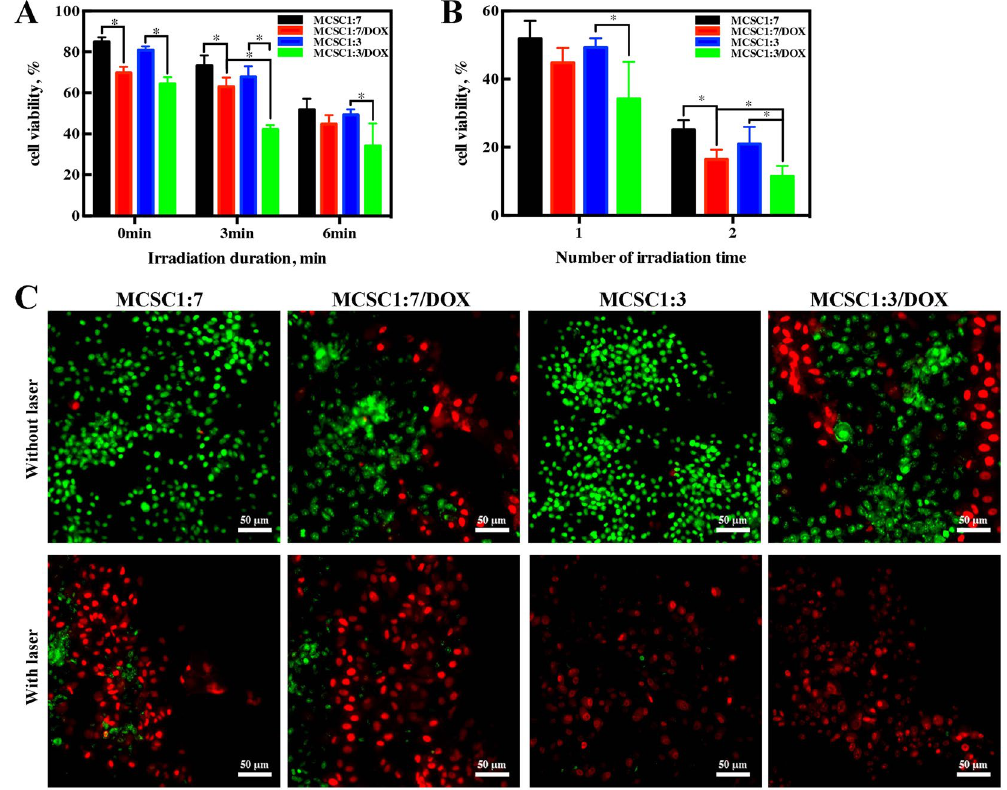
Figure 6. The scaffolds exert potent anti-proliferative effects on cancer cells in vitro . MG-63 cell viability post MCSC 1:7, MCSC 1:7/DOX, MCSC 1:3 and MCSC 1:3/DOX scaffolds treatment for 48 h with or without NIR irradiation ( A ) and indicated NIR irradiation times ( B ). ( C ) Cell viability based on Live/Dead assays, green for live cells and red for dead cells (all scale bars = 50 μ m). * P <